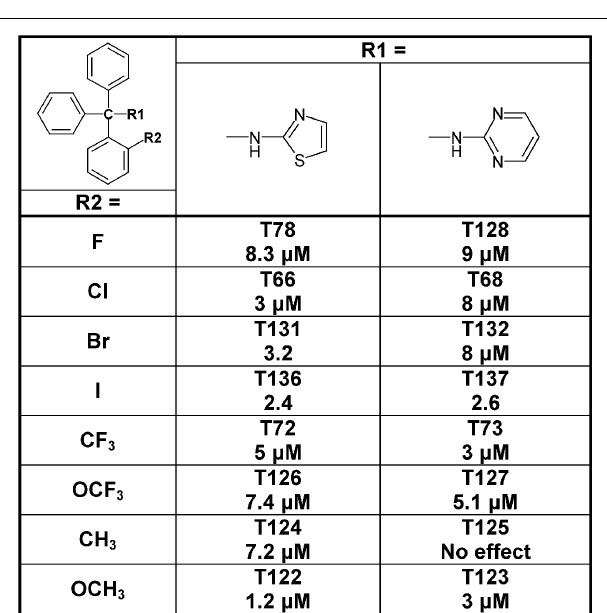
FIGURE 5 |Table showing the structures and IC 50 values for Cx50 inhibition for imidazole, pyrazole, aminothiazole, and aminopyrimidine substituted triarylmethanes bearing a chlorine substituent in various positions on one of the phenyl rings. Means of current inhibition and SD